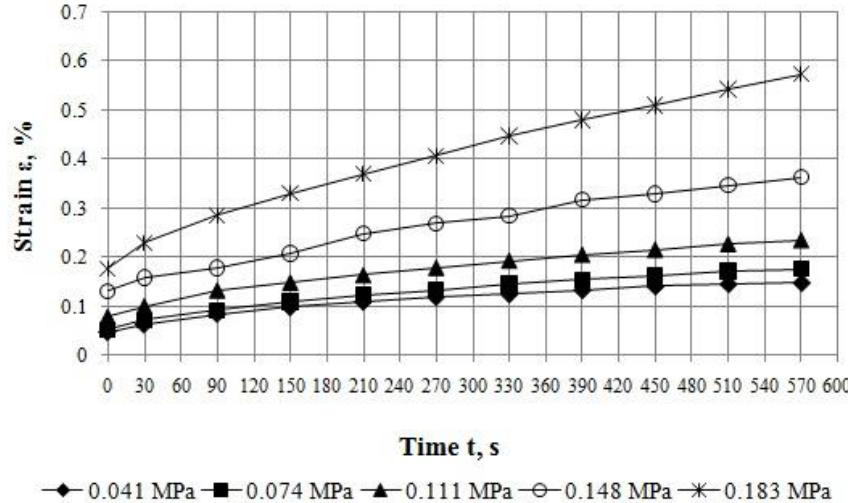
Figure 7. Creep curves of the asphalt concrete at various stresses.